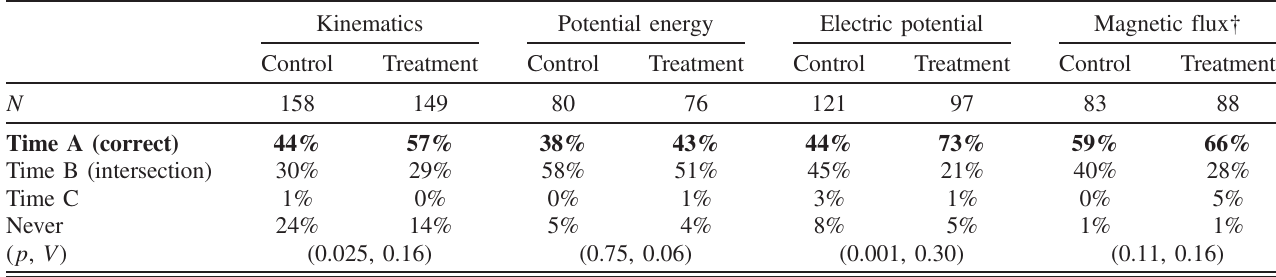
TABLE III. Answer distribution comparison between control (multiple choice with explanation) and treatment (chaining format) for each graph task in experiment 1B. The tasks themselves are shown in the Appendix. † Data collected from the previous year for magnetic flux task. See Sec. V B 3. The correct answer choice is in boldface for